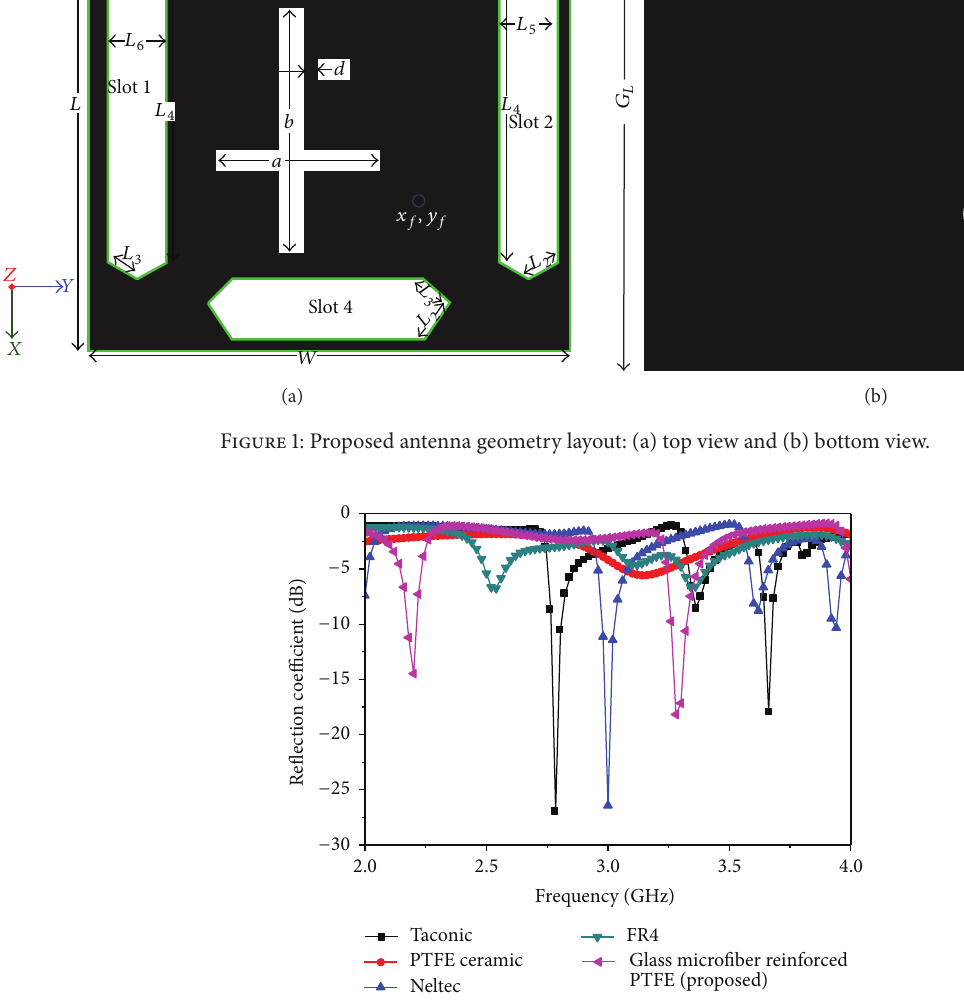
Figure 2: Reflection coefficient for different substrate